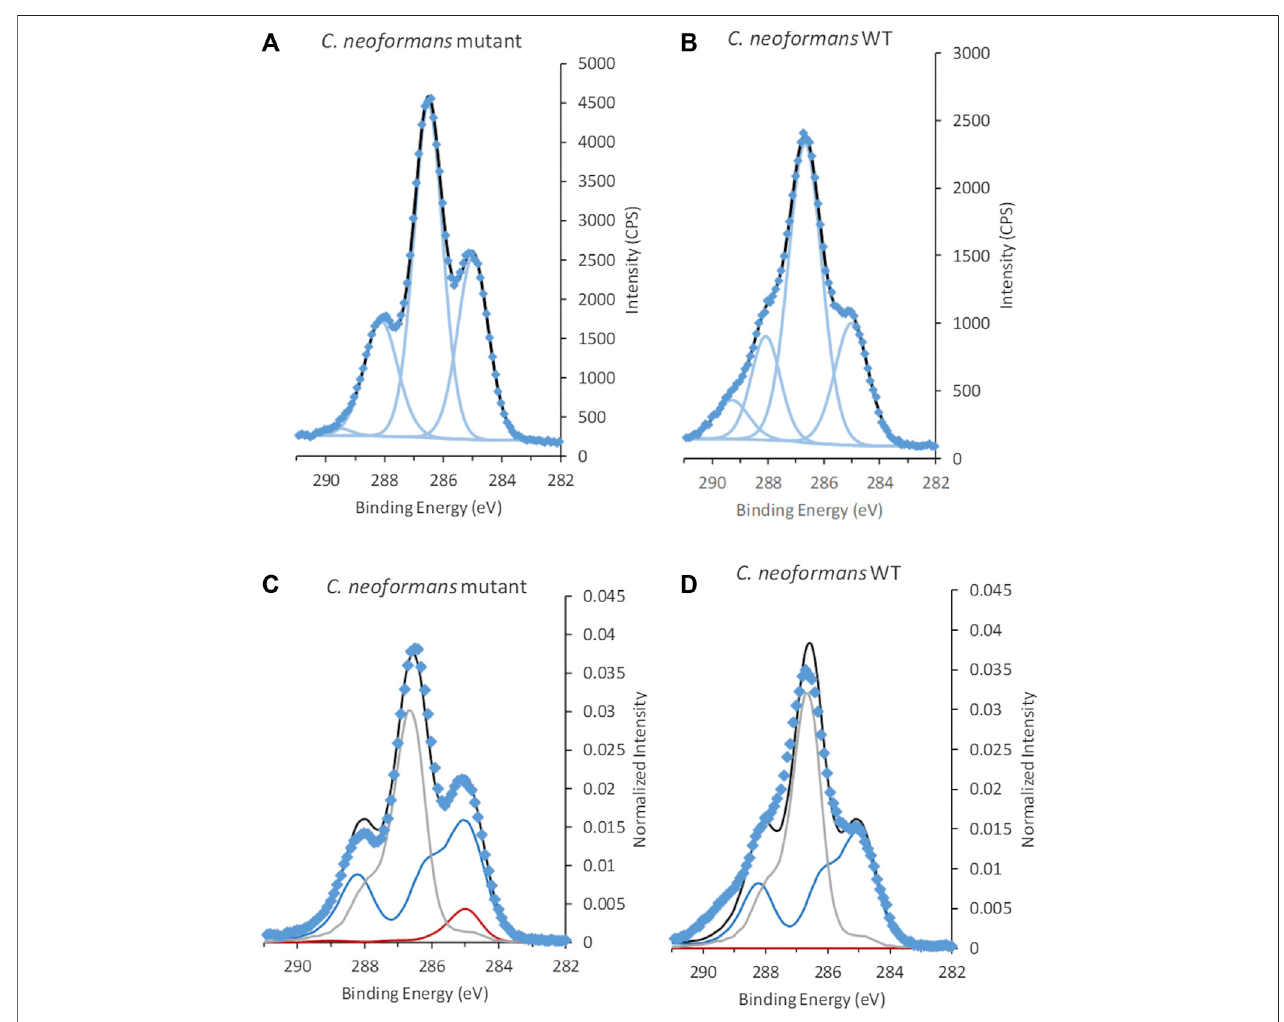
FIGURE5| C1sspectrafrom C.neoformans (A,C) mutantwithoutcapsuleand (B,D) wildtype(WT)withcapsule.Spectrain (A,B) are fi ttedusingtraditional fi tting of Gaussian-Lorentzian (GL30) peak shapes, (C,D) fi tted using spectral components. Data is represented by blue diamonds, the fi t by a solid black line, GL30 peak shapes are represented by light blue lines in fi gures (A,B) , and in (C,D) the blue line represents protein-like substance, grey line polysaccharides and red line lipid-like substances.